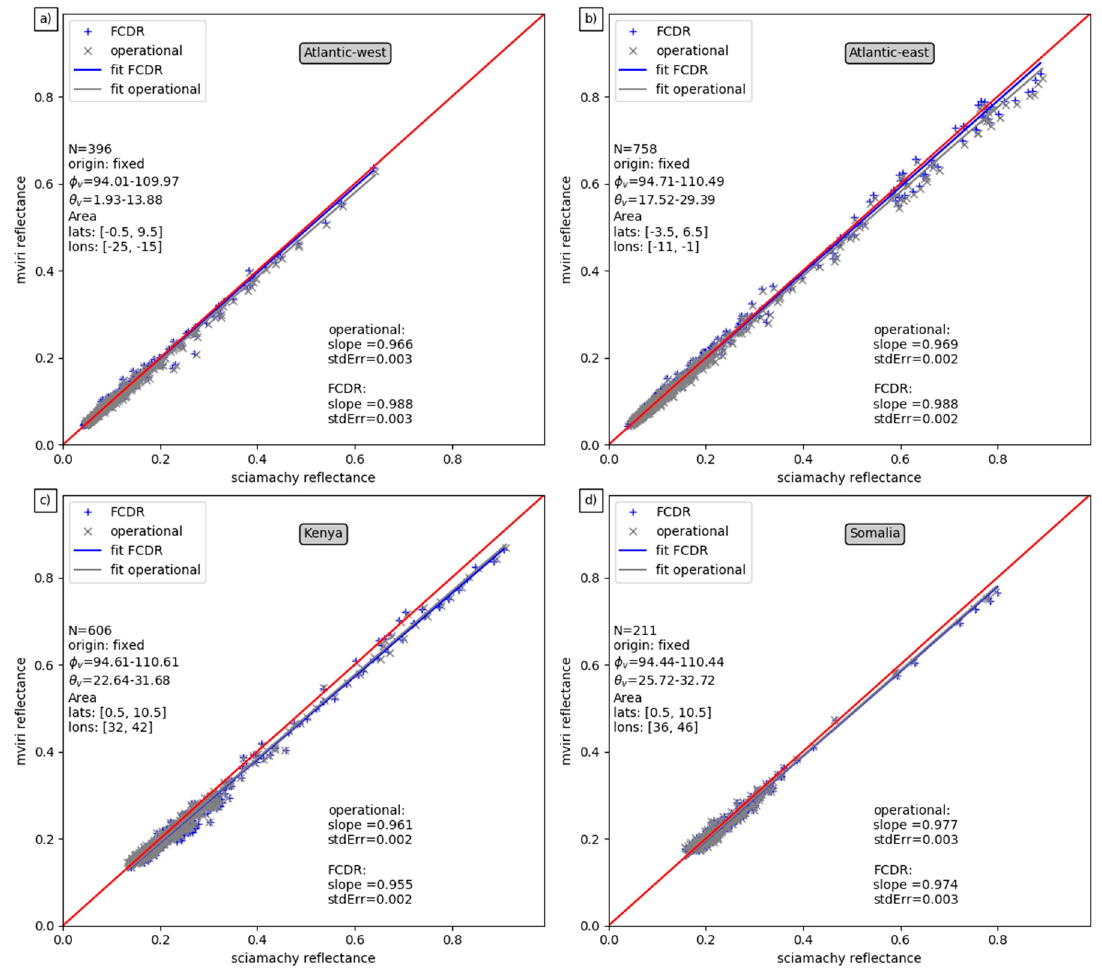
Figure 16. Collocations between SCIAMACHY and MVIRI onboard MET7 for ( a ) Atlantic-west, ( b ) Atlantic-east and ( c ) Kenya. Collocations between SCIAMACHY and MET5 are provided in ( d ) for Somalia. Grey marks stand for the dataset with the pre-launch SRF characterisation. Blue crosses stand for the harmonised/recalibrated FCDR. The collocations are constrained to relative azimuth angles between the two instruments of 5°, to zenith angle differences of 15° and to acquisition time differences of 5 min. Only collocations with MVIRI standard deviation of below 0.12 within a SCIAMACHY pixel are considered. Over the Atlantic areas and the Somalian area collocations were acquired from data collected during 2002–2006, whereas data collected during 2006–2010 were used for the collocations over the Kenyan area.